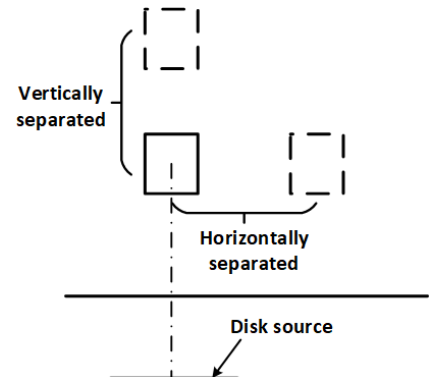
Two ways of arranging two detectors to measure the flux from the disk source. The horizontally-separated arrangement allows both fluxes to be measured simultaneously because none of the detectors is